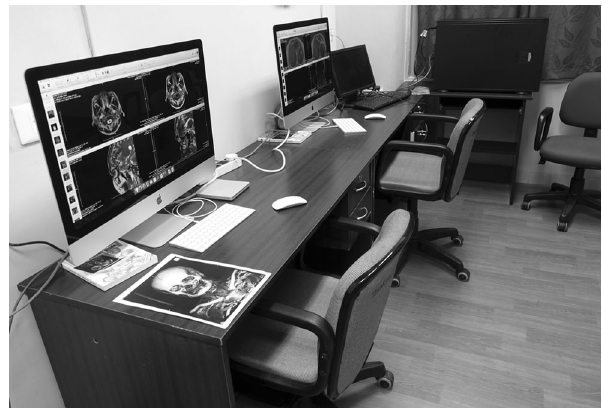
Fig. 3 The setup of the radiology reading room after installation of the two OsiriX